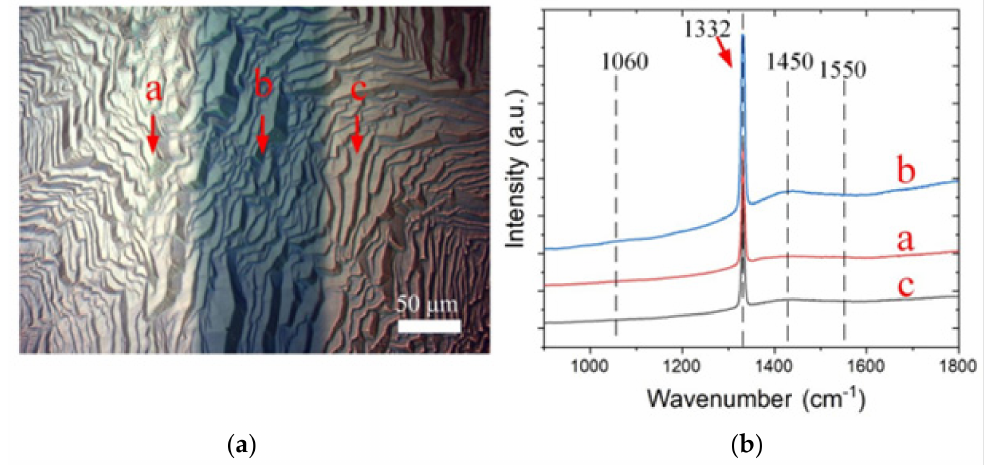
Figure 5. ( a ) SEM image after the growth; ( b ) Raman spectra taken from different locations around the channel (as shown in the adjacent images).